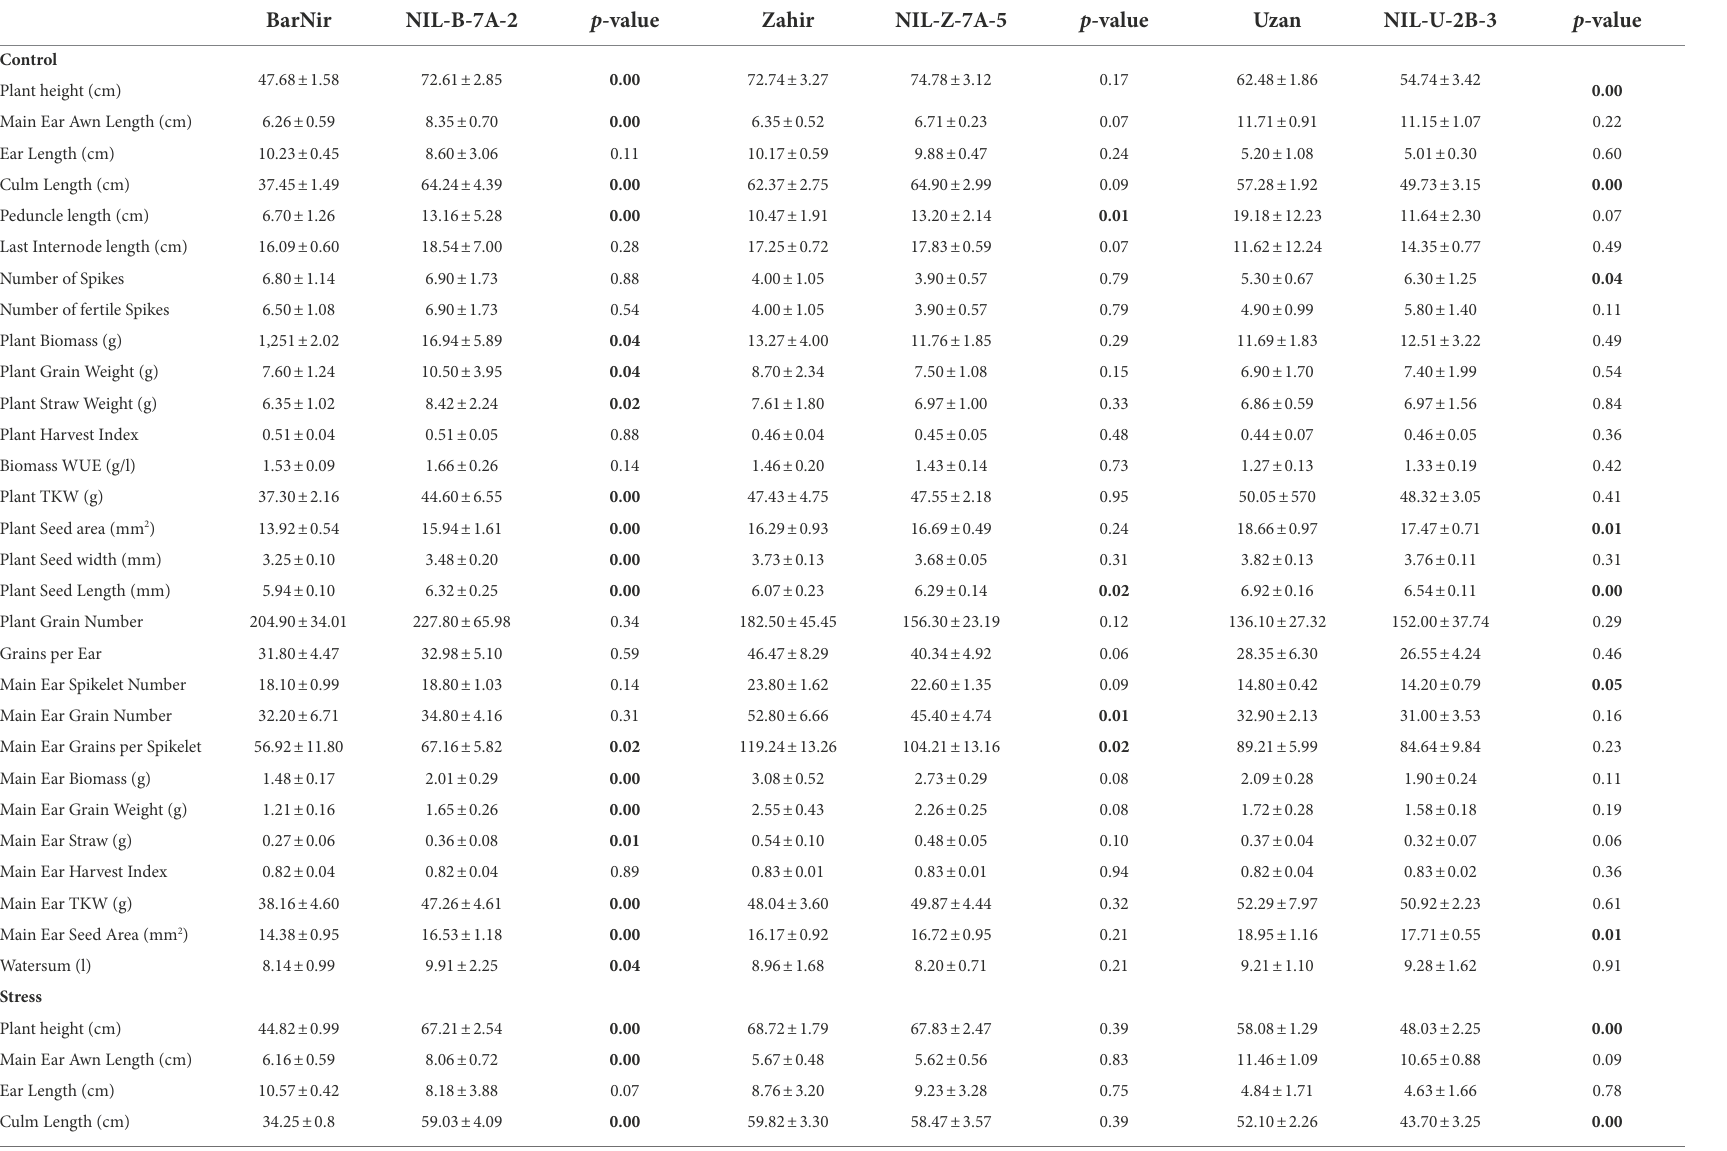
TABLE 4 Averages and standard deviation and significant differences ( t -test) between parents and corresponding NIL of traits manually measured at